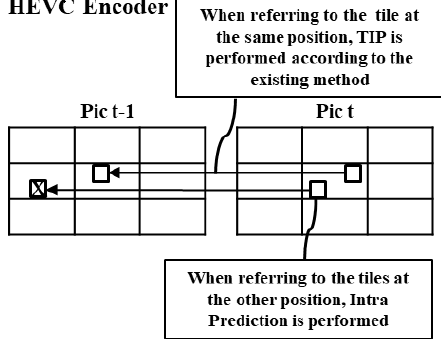
Figure 9. MCTS: TIP perform at the HEVC